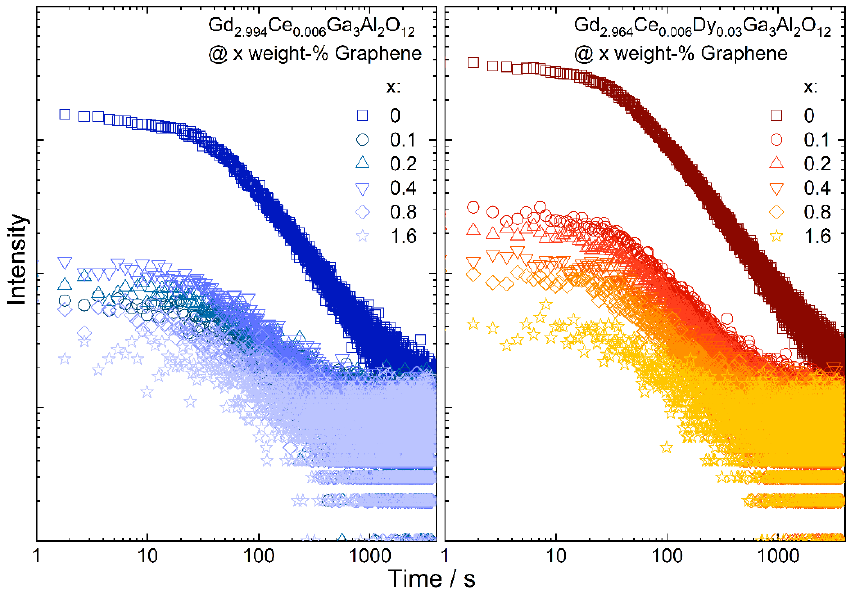
Figure 7. Persistent luminescence fading observed in Gd 2.994 Ce 0.006 Ga 3 Al 2 O 12 and Gd 2.964 Ce 0.006 Dy 0.03 Ga 3 Al 2 O 12 ceramics with different graphene content. Table 3. Average fading time of persistent luminescence observed in Gd 2.994 Ce 0.006 Ga 3 Al 2 O 12 and